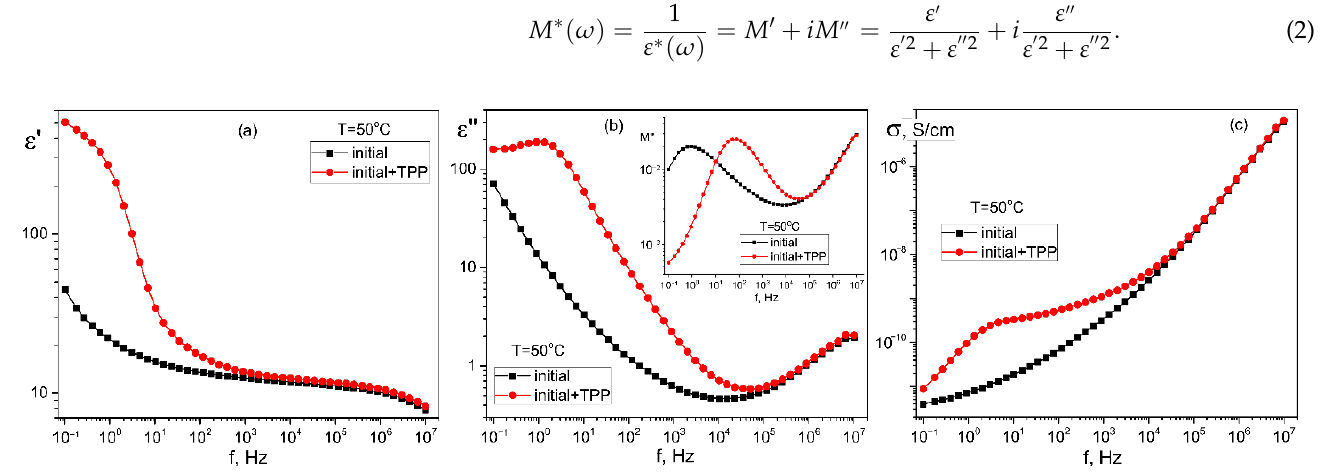
Figure 7. Comparison of the frequency dependences of the real ε ′ (f) ( a ) and imaginary ε ″ (f) ( b ) components of the complex dielectric permittivity and the real part of the AC-conductivity σ (f) ( c ) in the initial and TPP-doped P(VDF-HFP) copolymer films crystallized from acetone; in the insert in Figure 7b — frequency dependences of the imaginary part of the electric modulus M ″ (f). T = 50 °C.